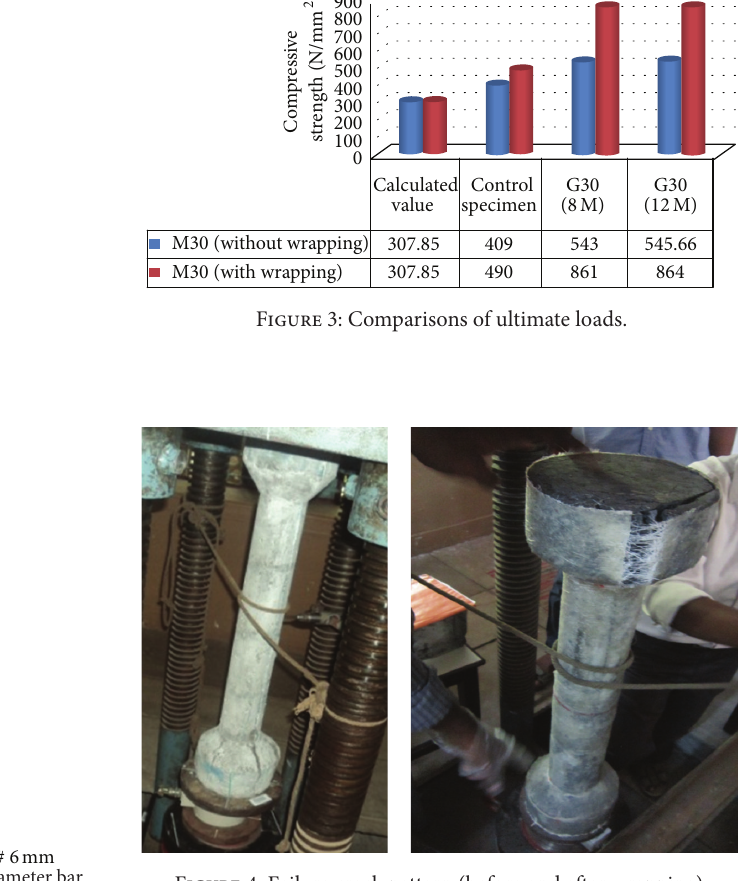
Figure 4: Failure crack pattern (before and after